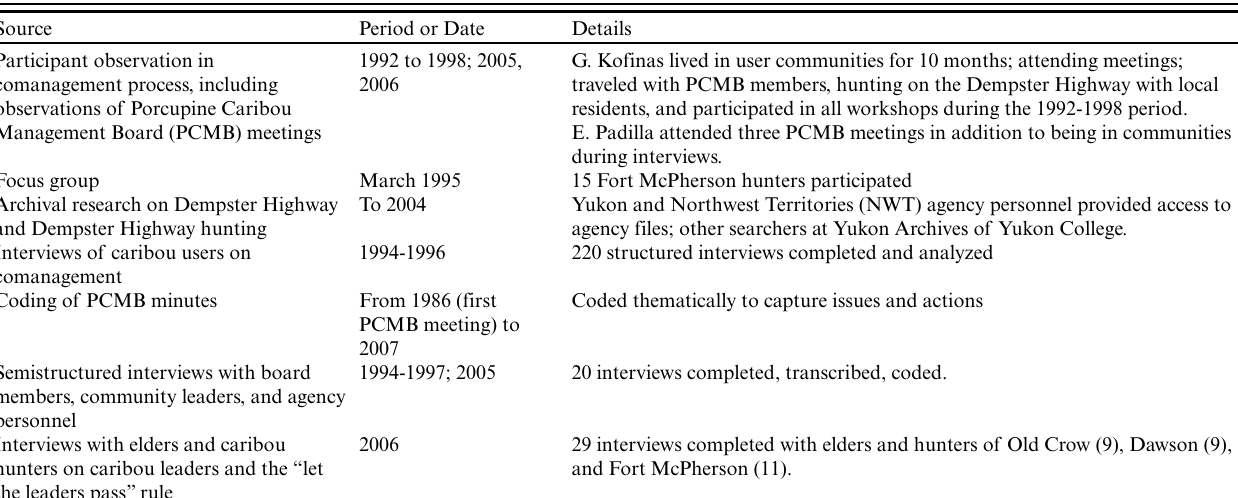
Table 2 . Sources of